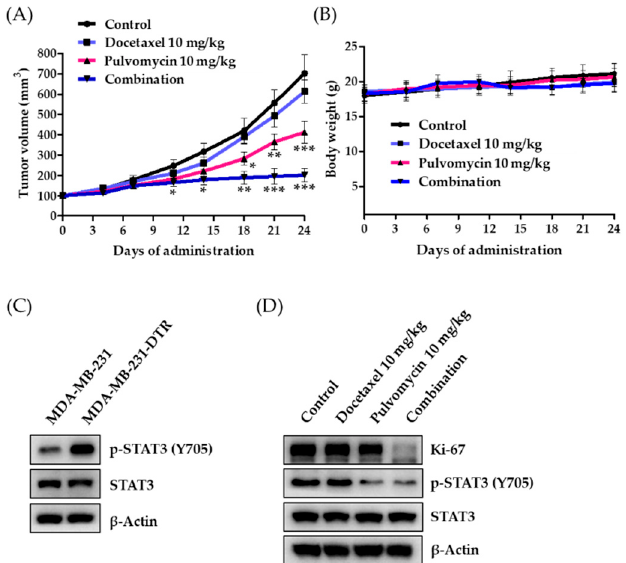
Figure 6. The combined administration of pulvomycin and docetaxel can overcome docetaxel resistance in an in vivo xenograft model. ( A ) Tumor volumes of the MDA-MB-231-DTR xenograft mouse model intraperitoneally administered vehicle, docetaxel, pulvomycin, or a combination of docetaxel (10 mg/kg body weight) and pulvomycin (10 mg/kg body weight) three times per week for 24 days were measured every 3–4 days with an electronic caliper. * p < 0.05, ** p < 0.01, and *** p < 0.001 were compared with the vehicle-administered control group. ( B ) Mouse body weights were measured every 3–4 days to assess general toxicity. ( C ) Small portions of tumor tissue from each group were homogenized in complete lysis buffer (Active Motif). Levels of p-STAT3 (Y705) and STAT3 expression were determined using Western blot analysis. β -Actin was used as an internal control. ( D ) Small portions of tumor tissue from each group were homogenized in complete lysis buffer (Active Motif). Levels of Ki-67, p-STAT3 (Y705), and STAT3 expression were determined using Western blot analysis. β -Actin was used as an internal control.